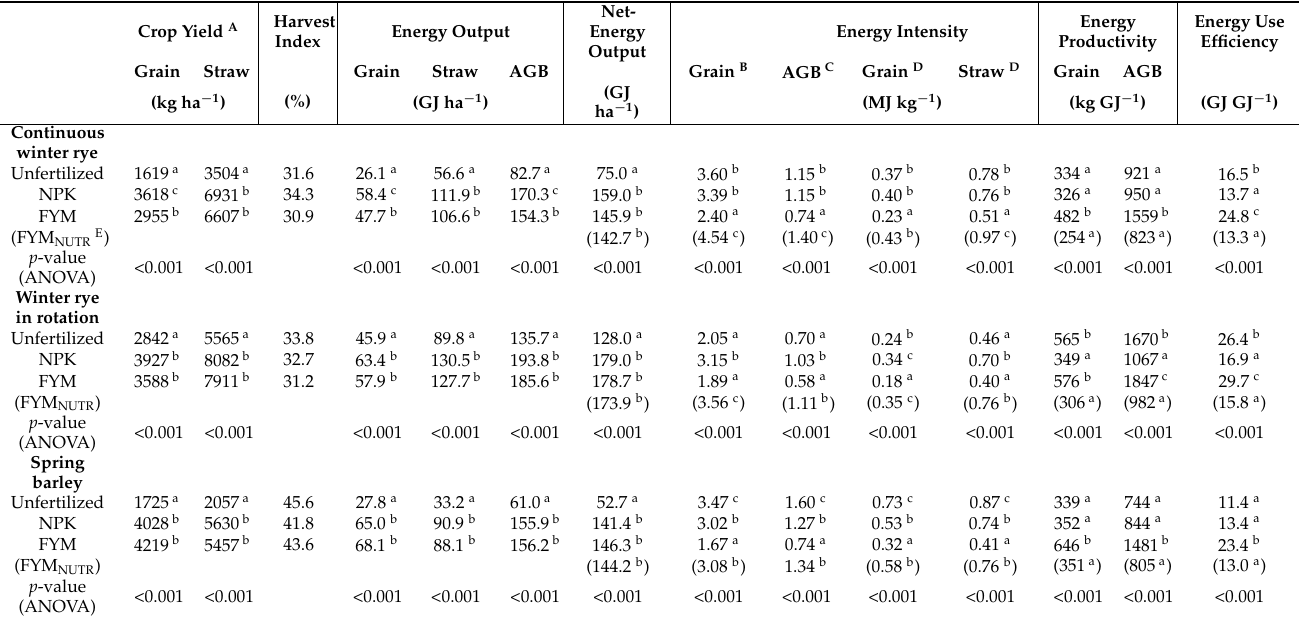
Table 7. Crop yield and energy efficiency indicators for continuous winter rye, winter rye in rotation and spring barley in rotation (mean over years